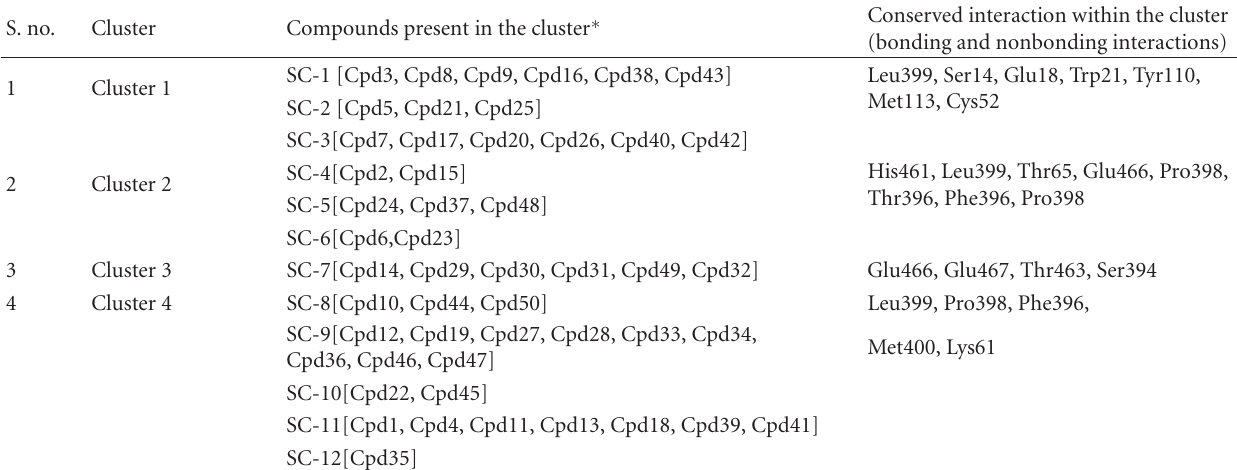
Table 2: Table showing conserved interaction of ligands with active site residues of TR within clusters. S. no. Cluster Compounds present in the cluster ∗